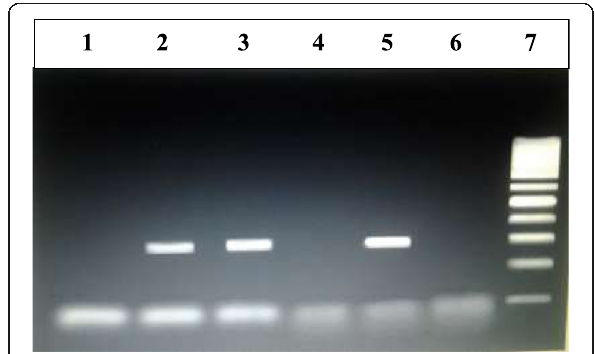
Fig. 1 Agarose gel stained with ethidium bromide, for detection of TEM genes in P. aeruginosa . Lanes 1, 4 and 6 are negative. Lanes 2, 3 and 5 are positive tests for TEM (296 bp). Line 7 is a DNA ladder (Fermentas, Germany)